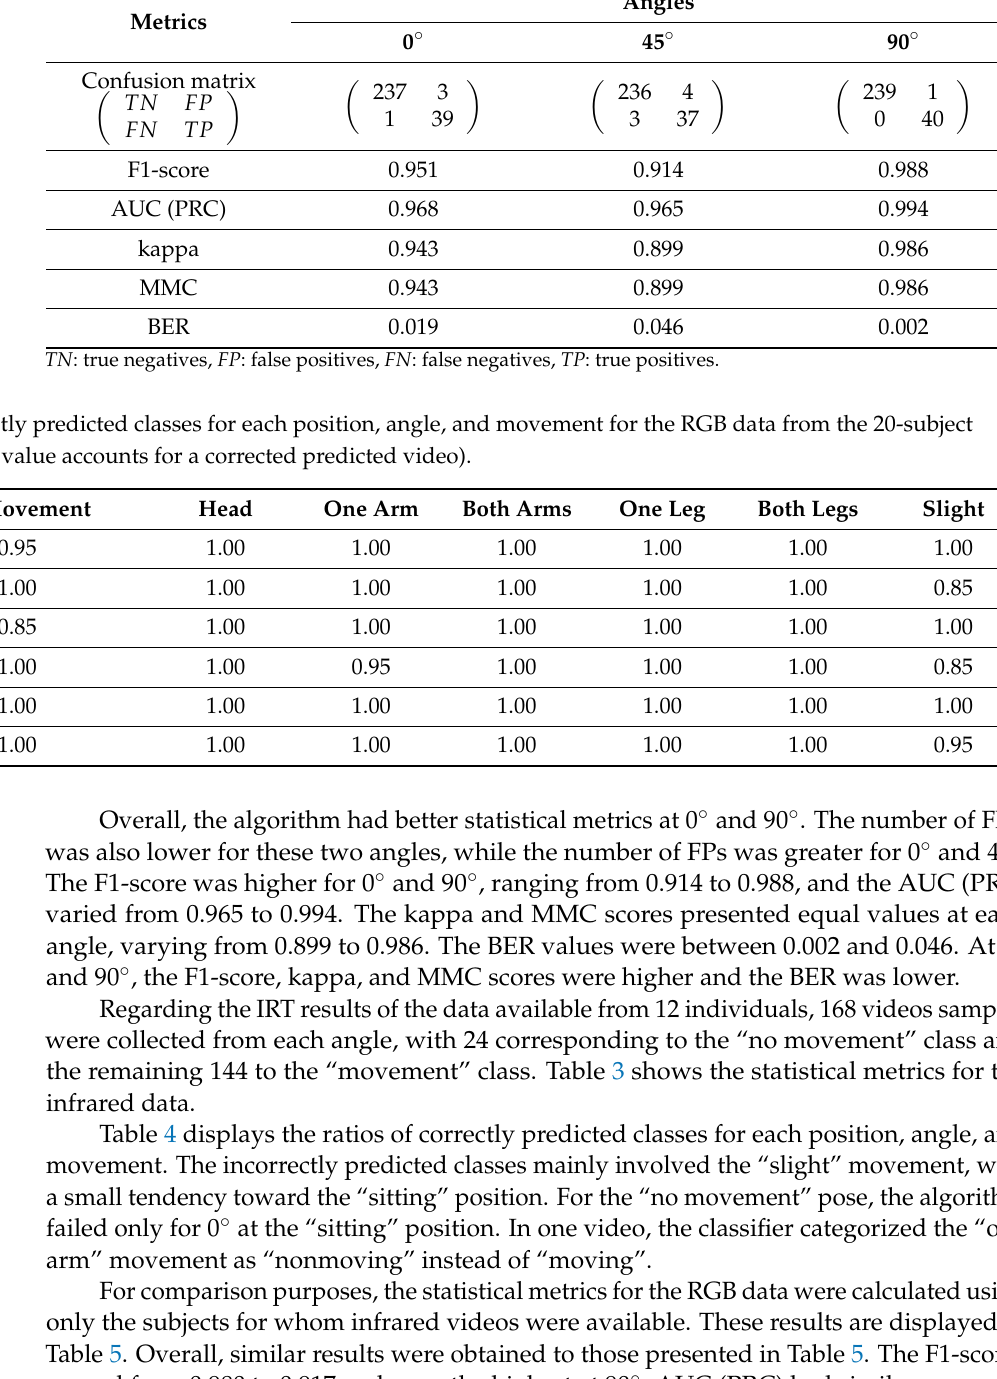
respectively. Lastly, BER was lowest at 90 ◦ , followed by 0 ◦ and 45 ◦ , ranging between 0.003 and